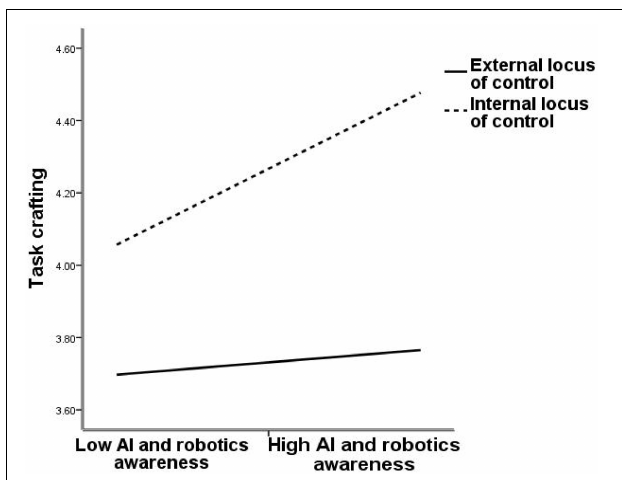
FIGURE 3 | Interaction effect of locus of control and AIRA on task crafting.